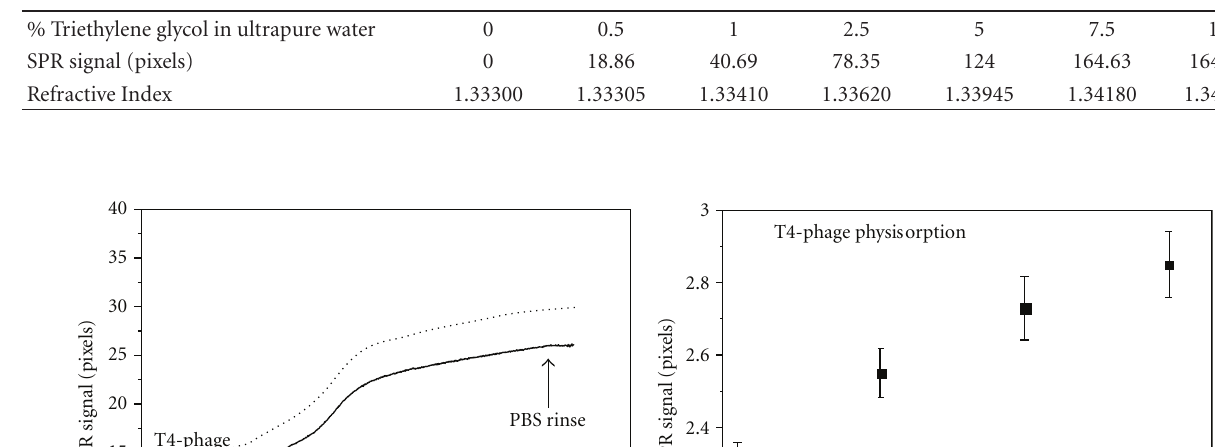
Table 1: SPRi signal and refractive index of the external medium obtained with di ff erent percentage of triethylene glycol per 1mL of ultrapure water.